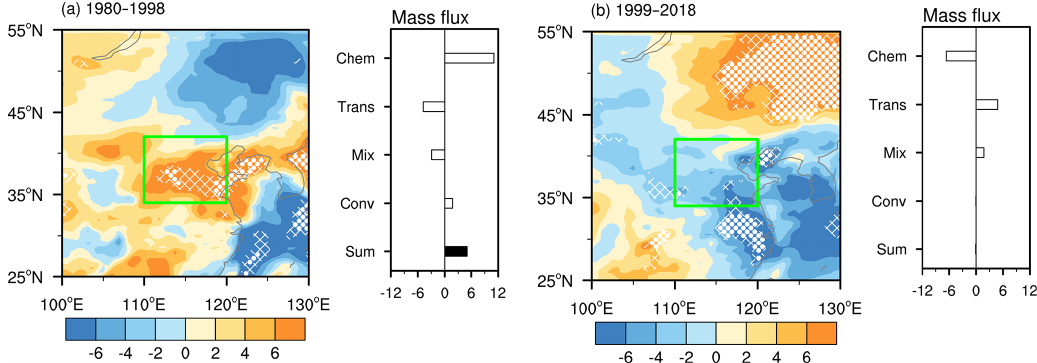
Figure 8. Composite difference of the summer MDA8 O 3 (unit: µgm − 3 ) simulated by the GEOS-Chem model between the three lowest and the three highest SC WS years (a) from 1980 to 1998 and (b) from 1999 to 2018. The white dots (hatching) indicate that the difference was above the 95% (90%) confidence level ( t test). The green boxes represent the location of North China. The bar chart on the right is the composite difference of the summer mass fluxes of ozone (unit: td − 1 ) during each periods. The left axis gives the names of the physicochemical processes: chemical reaction (Chem), transport (Trans), PBL mixing (Mix), convection (Conv) and their sum (Sum). The results were calculated within the planetary boundary